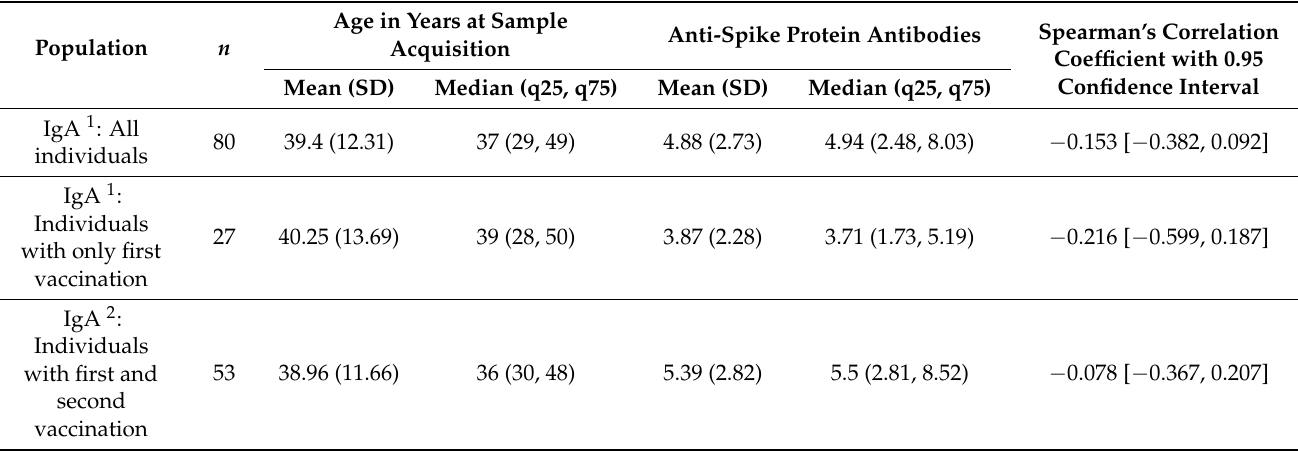
Table 2. Spearman’s correlation coefficients between the age at the sample acquisition date and the anti-spike protein antibody titers. The p -value for age at sample acquisition was 0.00238. The p -value for anti-spike protein IgA antibodies was 0.00008 and for IgG anti-bodies